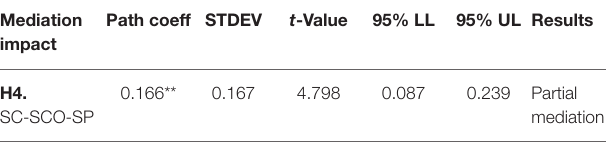
TABLE 5 | Findings of hypothesis testing. TABLE 6 | Mediation analysis for directs and indirects